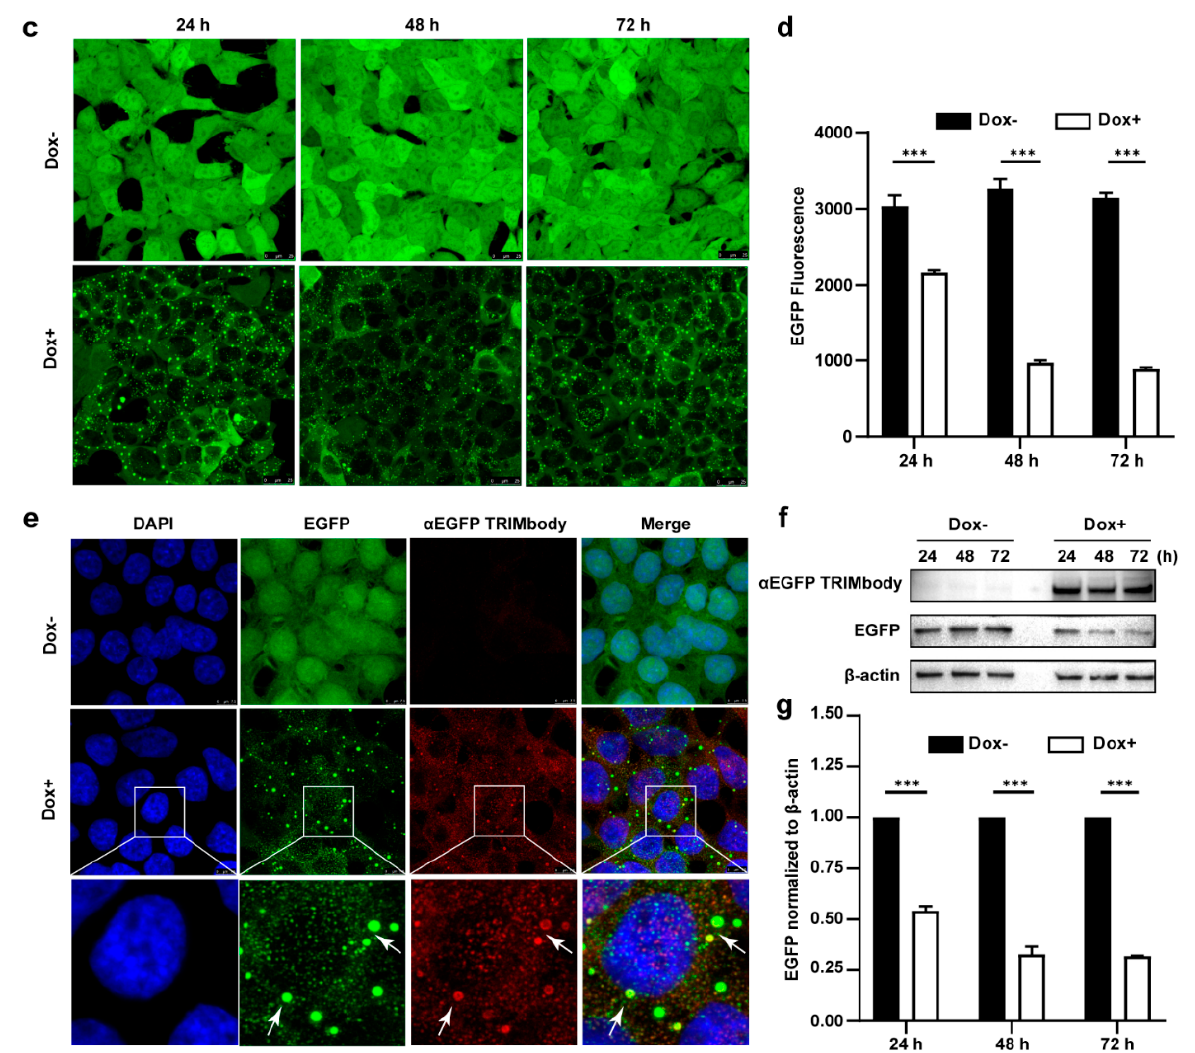
Figure 2. Degradation of EGFP by α EGFP TRIMbody. ( a ) Stable expressing EGFP 293T cell lines were analyzed by flow cytometry. At least 15,000 cells were counted for each experiment. Percentages correspond to EGFP-positive cells falling within the gate were drawn. ( b ) EGFP expressing was decreased in cells after α EGFP TRIMbody transfection. Error bars indicate standard deviations ( n = 3). ( c ) The inducible expression of α EGFP TRIMbody by Dox treatment in stable HEK293T-EGFP cells caused EGFP degradation. Scale bars, 25 µ m. ( d ) Mean fluorescence intensity of EGFP in cells untreated or treated with Dox. Mean fluorescence intensity was measured using flow cytometry and indicated by bar graphs ( n = 3 replicates per group). Data represent the mean ± SEM. *** p < 0.001 represents statistical significance. ( e ) Subcellular localization of α EGFP TRIMbody and EGFP in α EGFP TRIMbody-inducible and EGFP-stable expressing cells. Nuclei were stained with Hoechst 33342; green represents the EGFP protein, red represents the α EGFP TRIMbody tagged with anti-Flag antibody conjugated-Alexa ® Fluor 594. White arrows indicate co-localization of EGFP and α EGFP TRIMbody in cytosol of the cells. Scale bars, 7.5 µ m. ( f , g ) The degradation of EGFP was determined by Western blot analysis. Cells were treated with Dox for 72 h and equal amounts of cell lysates (10 µ g) were loaded in each well. Through immunoblotting with anti-Flag antibody, the relative optical density of bands on the blots was analyzed by software. Values are the mean ± SEM ( n = 3/group). Statistical significance between ligands were determined using a two-way ANOVA test. *** p < 0.001 versus